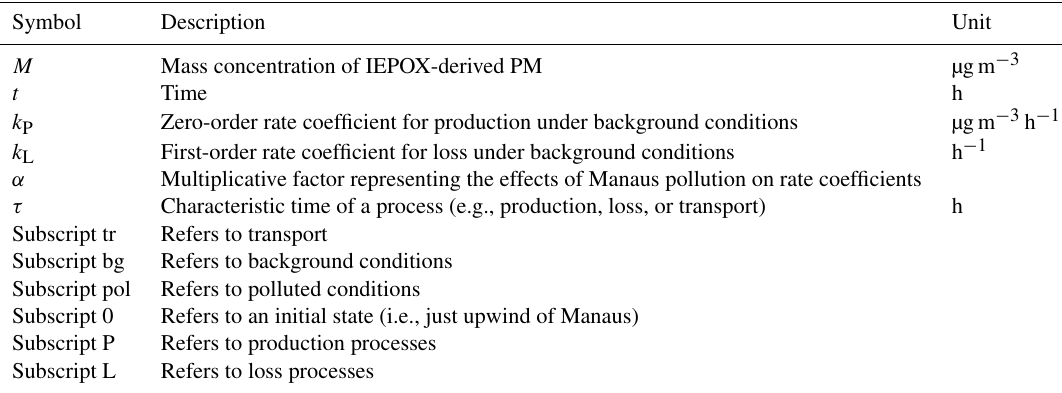
Table 2. Descriptions and units of symbols in the model. Symbol Description Unit Mass concentration of IEPOX-derived PM Zero-order rate coefficient for production under background conditions First-order rate coefficient for loss under background conditions h − 1 Multiplicative factor representing the effects of Manaus pollution on rate coefficients Characteristic time of a process (e.g., production, loss, or transport)